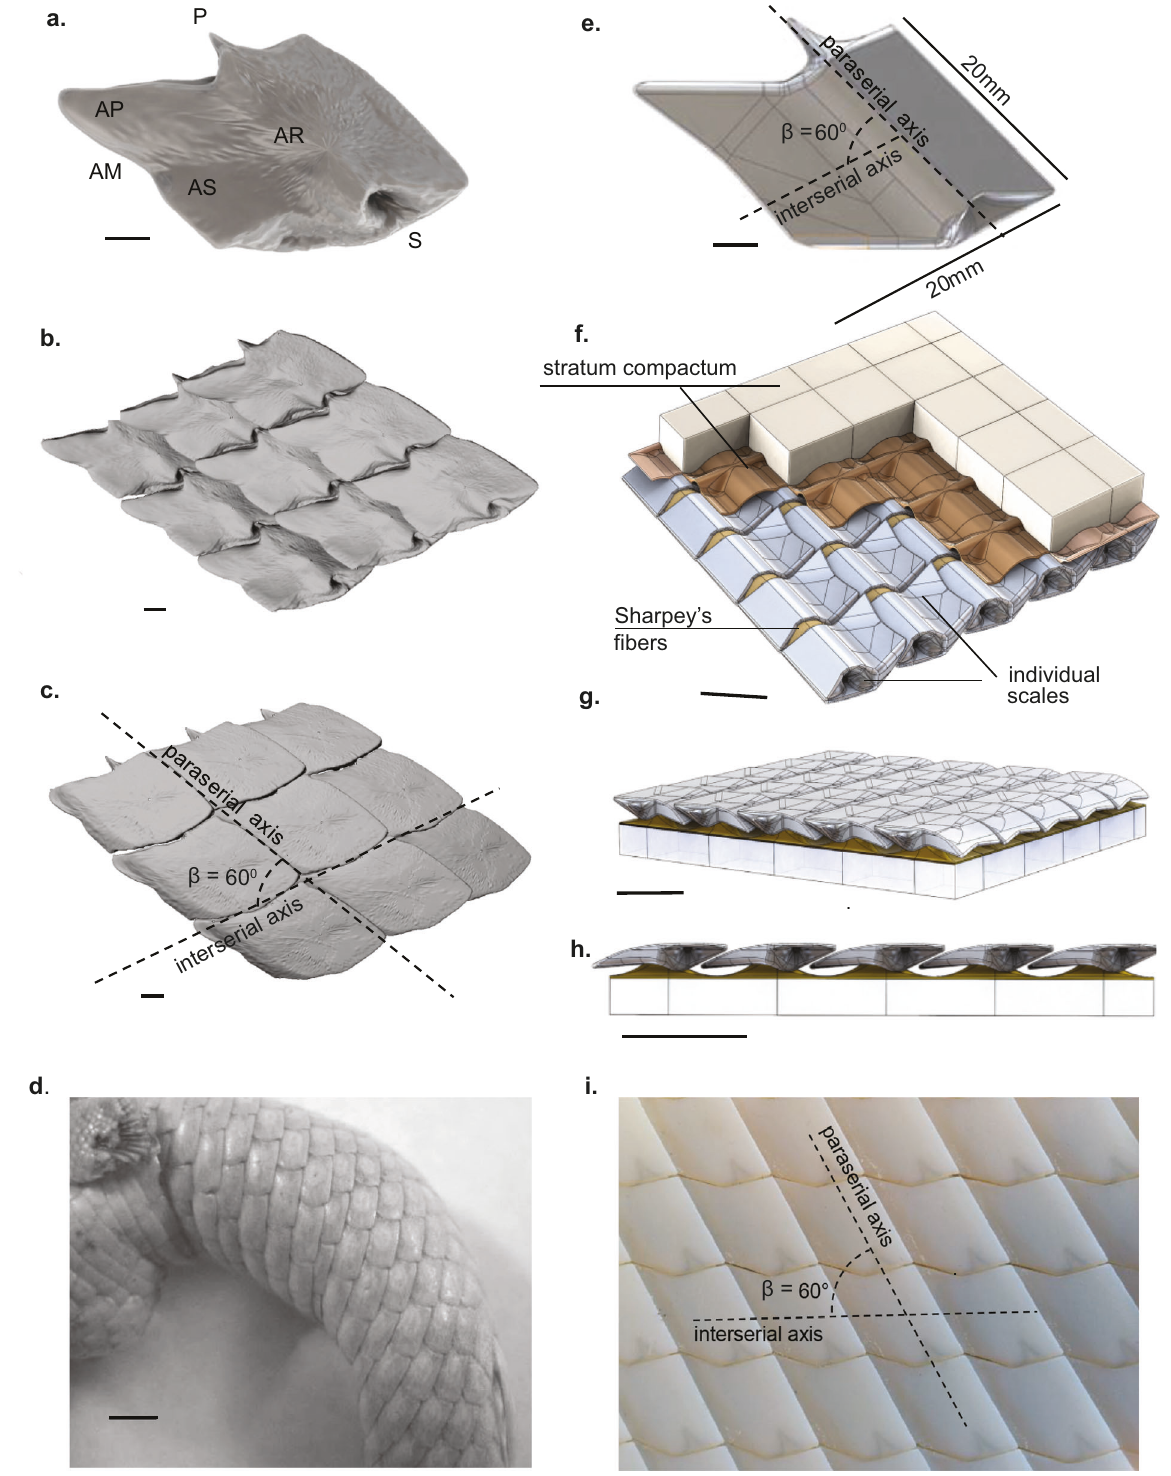
Fig. 2 Translation of the biological design rules to a synthetic fl exible composite material. a 3D µ CT reconstruction of an averaged scale highlighting geometrical features: peg (P), socket (S), anterior process (AP), anterior shelf (AS), concave anterior margin (AM), and axial ridge (AR). Scale bar = 1 mm. b Homogeneous assembly of the biological scale geometry, interior view (scale bar = 1 mm), and c exterior view, showing the paraserial and interserial axes oriented at angle β = 60° from each other. Scale bar = 1 mm. d A photograph of the biological exoskeleton in a deceased P. senegalus specimen. Scale bar = 5 mm. e Abstracted geometry (3D model) of a single scale unit magni fi ed to 20 mm length. Scale bar = 1 mm. f Associative 3D model of the scale assembly that incorporates the essential parts of the exoskeletal assembly, including the scales, substrate, paraserial connections, and scale – substrate attachment, interior view (scale bar = 20 mm), g exterior view (scale bar = 20 mm), and h cross-sectional view. Scale bar = 20 mm. i A photograph of a multi-material 3D-printed prototype of the scale